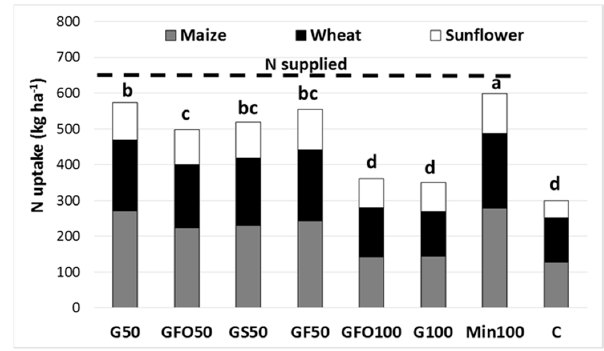
Figure 5. Cumulated nitrogen uptake (kg ha − 1 ) over the entire crop succession. Different letters indicate significant differences according to Tukey’s HSD test at p < 0.05. G50: 50% of N from G compost and 50% of N from mineral fertilization (MF). GFO50: 50% of N from G + F + O compost and 50% of N from MF. GS50: 50% of N from G + S compost and 50% of N from MF. GF50: 50% of N from G + F compost and 50% of N from MF. GFO100: 100% of N from G + F + O fertilization. G100: 100% of N from G compost. Min100: 100% of N from MF. C: Un-fertilized treatment.